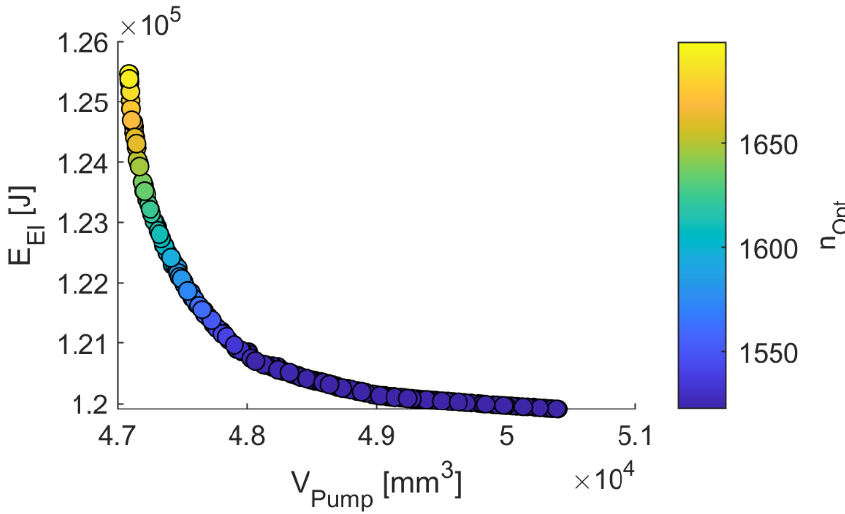
Figure 17. Pareto front of the technical variants of the coolant pump.